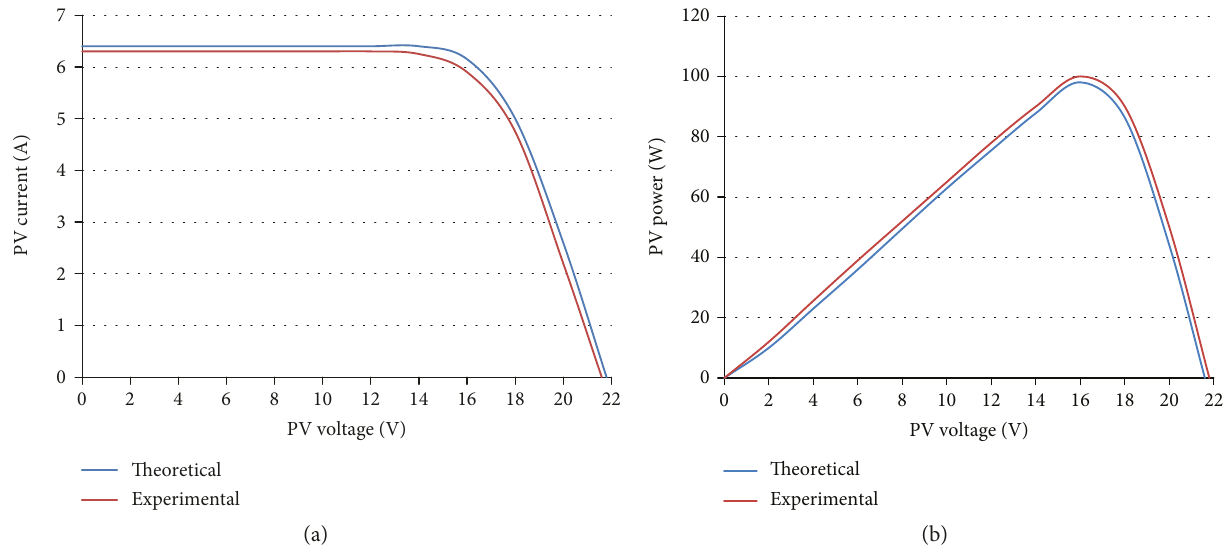
Figure 14: (a) Theoretical and experimental results comparison of I - V at 25 ° C, 1000 W/m 2 . (b) Theoretical and experimental results comparison of P - V at 25 ° C, 1000 W/m 2 .